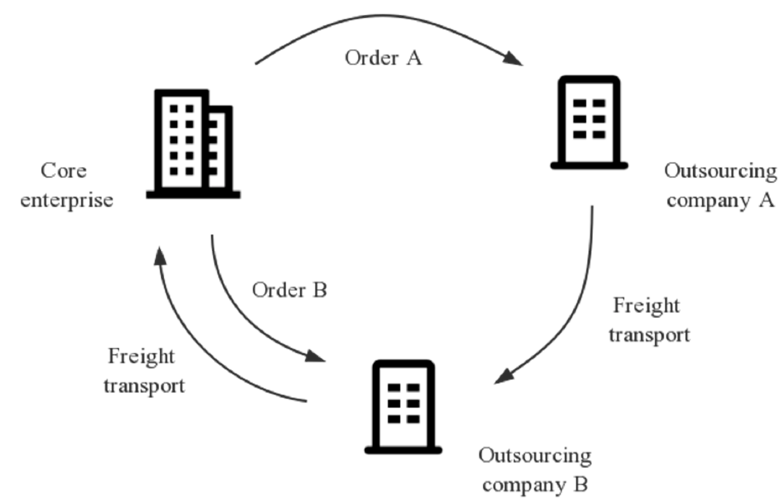
Figure 2. Processing relation diagram for external parts.